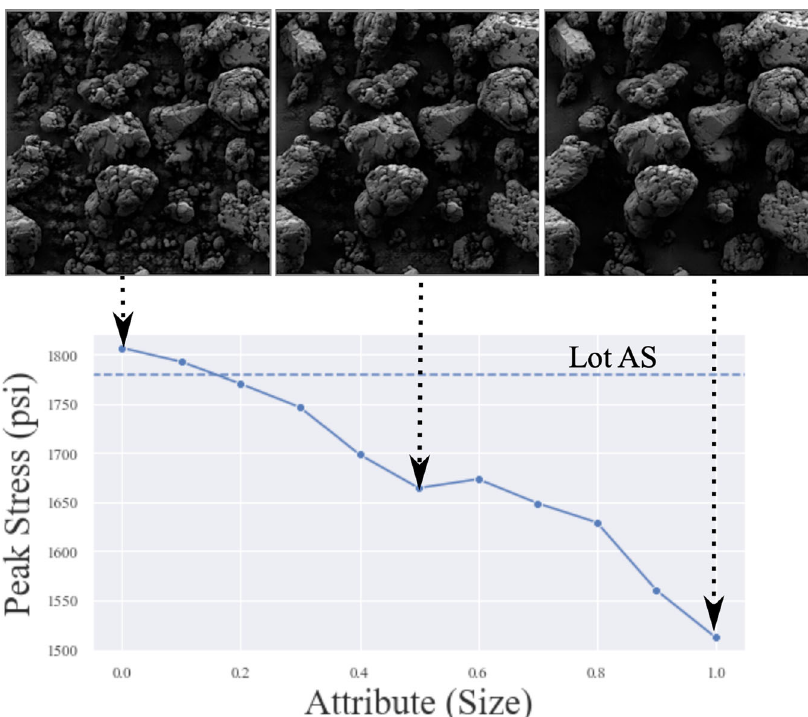
Fig. 16 Example explanation generating network. Material attribute aware visual explanations (i.e., synthetic images) are generated from an image editing GAN 129 . The top row shows synthetic SEM images generated with increasing average particle size input. The lower row shows predictions from an experimental data trained material strength prediction model, in which the x-axis shows the normalized size attribute value. These prediction results agree with materials domain knowledge (i.e., the Hall-Petch rule). The material attribute aware image generation model together with the forward property prediction model form a general framework that can explain the effect of abstract material attributes. Figure reprinted from ref. 129 with permission. Copyright 2022